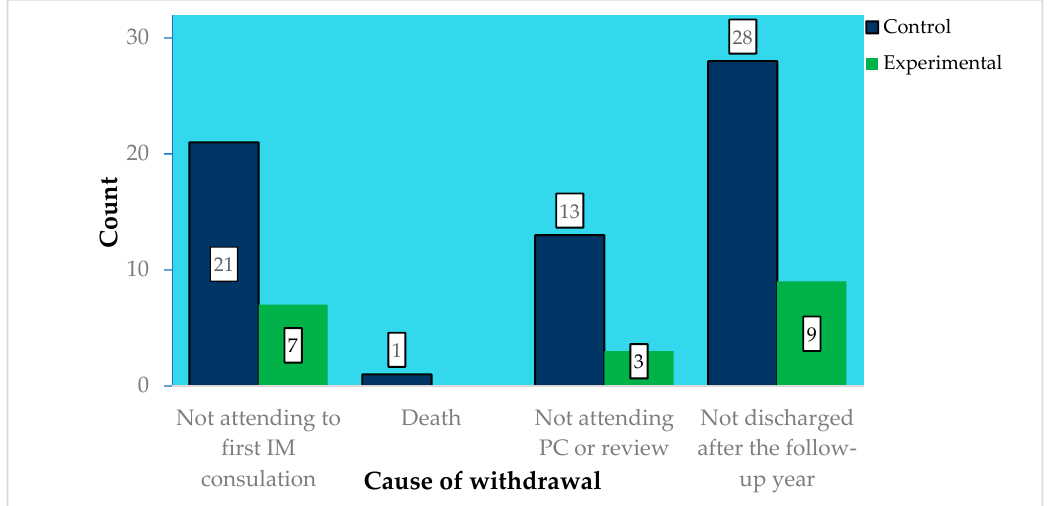
Figure 2. Withdrawn patients’ count by withdrawal cause.